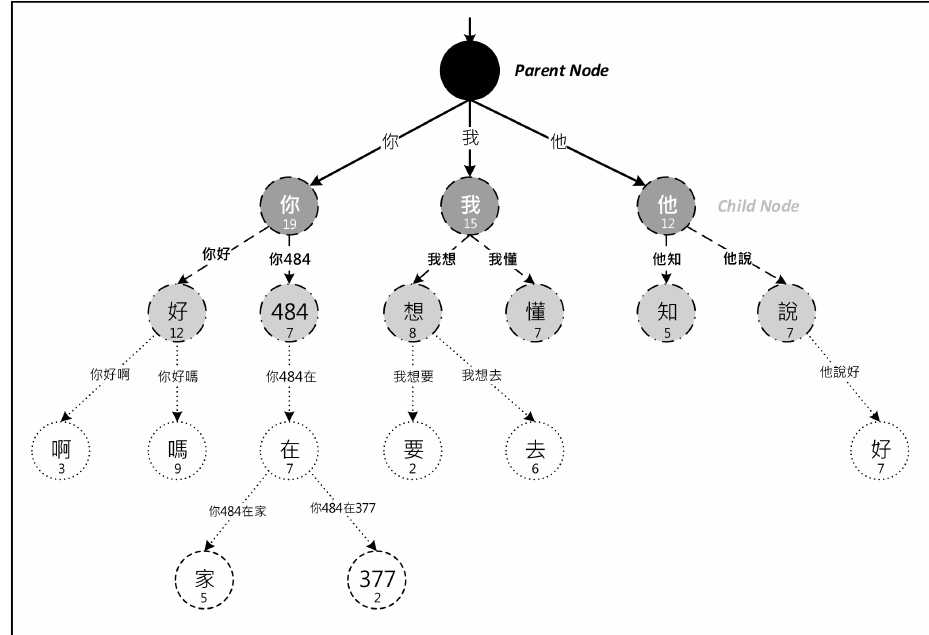
Figure 1. A sample Chinese retrieval